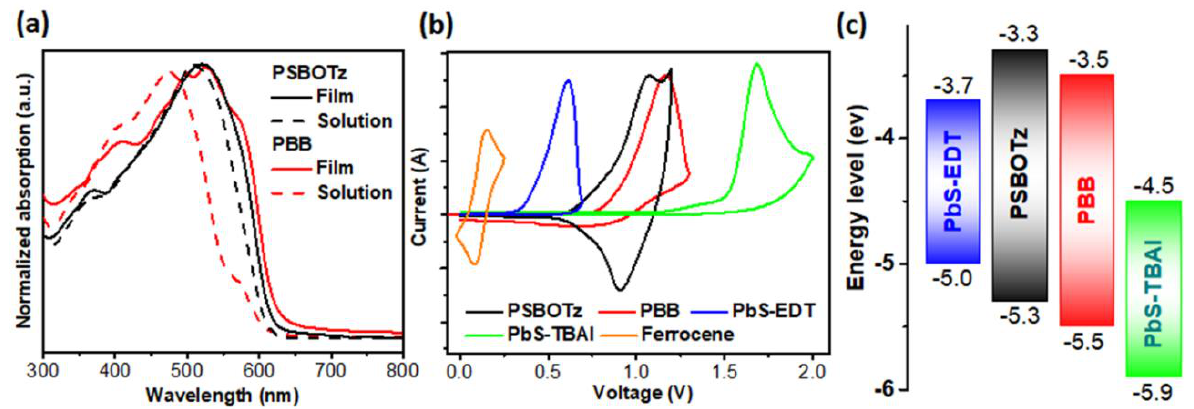
Figure 1. ( a ) UV-Vis absorption spectrum of the CPs in solution and in the film state. ( b ) CV plots of the study materials in the film state, and ( c ) energy diagrams extracted from the CV plots.